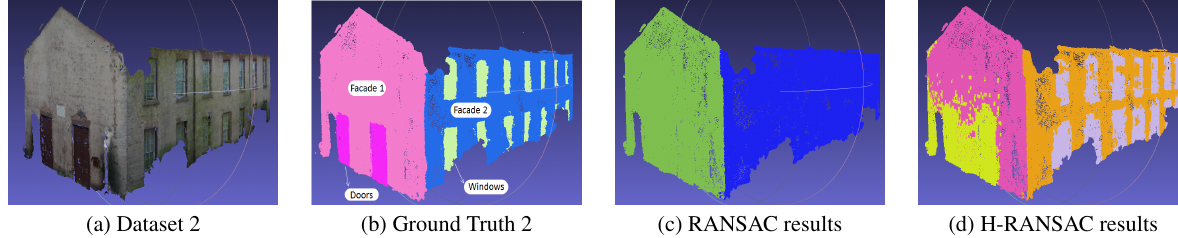
Figure 3. Gerrard-hall theater dataset: a) original point cloud, b) segments obtained after manual segmentation, c) segments obtained using only geometry features, d) segments obtained using both geometry and visual